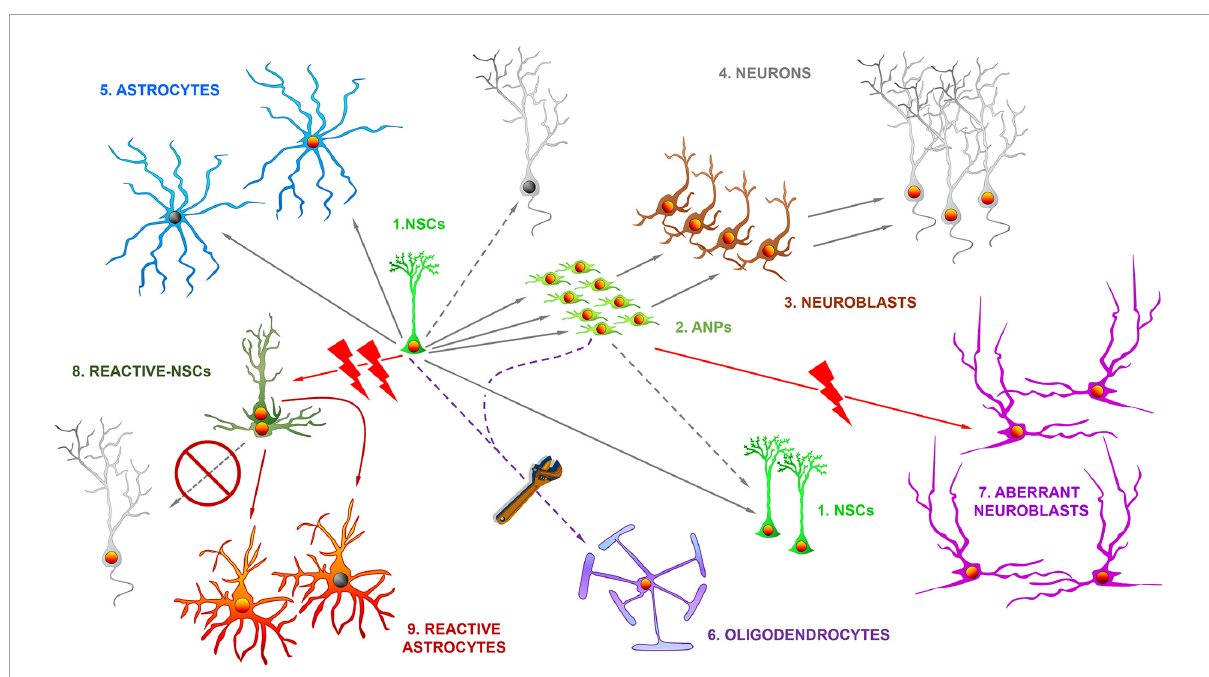
FIGURE1 The differential fate of multipotent adult hippocampal neural stem cells in health and disease. In normal conditions, the hippocampal neural stem cells (NSCs, 1) of the dentate gyrus get activated at a low rate and divide asymmetrically to generate amplifying neural progenitors (ANPs, 2) which ultimately differentiate into immature neurons (neuroblasts, 3) and ultimately in fully mature neurons (4) of the granule cell layer. The direct differentiation into neurons is also possible. NSCs also generate astrocytes (5) through ultimate differentiation. NSCs can also divide symmetrically to generate copies of themselves. By gene expression manipulation NSCs can also differentiate into oligodendrocytes (6). In situations of pathological neuronal hyperexcitation NSCs such as epilepsy, can generate aberrant neuroblasts (7), characterized by abnormal migration, dendritic arborization and dendritic spine density. In more extreme cases such as temporal lobe epilepsy with hippocampal sclerosis, NSCs abandon neurogenesis and transform into reactive-NSCs (8), which abandon neurogenesis, get activated massively to enter symmetric cell division and ultimately differentiate into reactive astrocytes